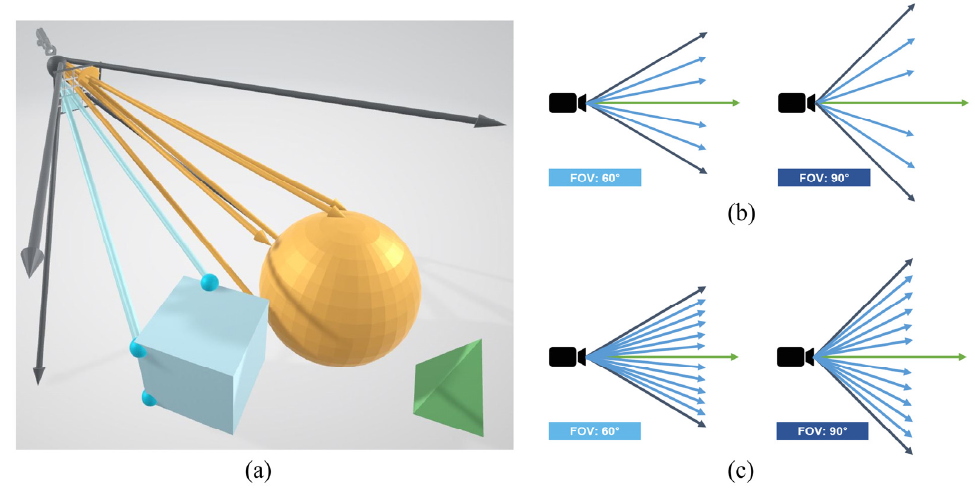
Figure 5. Basic principles of ray casting. ( a ) Obtaining the coordinates of the intersection points between light and object, ( b ) se tt ing fi eld of view (FOV), and ( c ) se tt ing the number of rays.